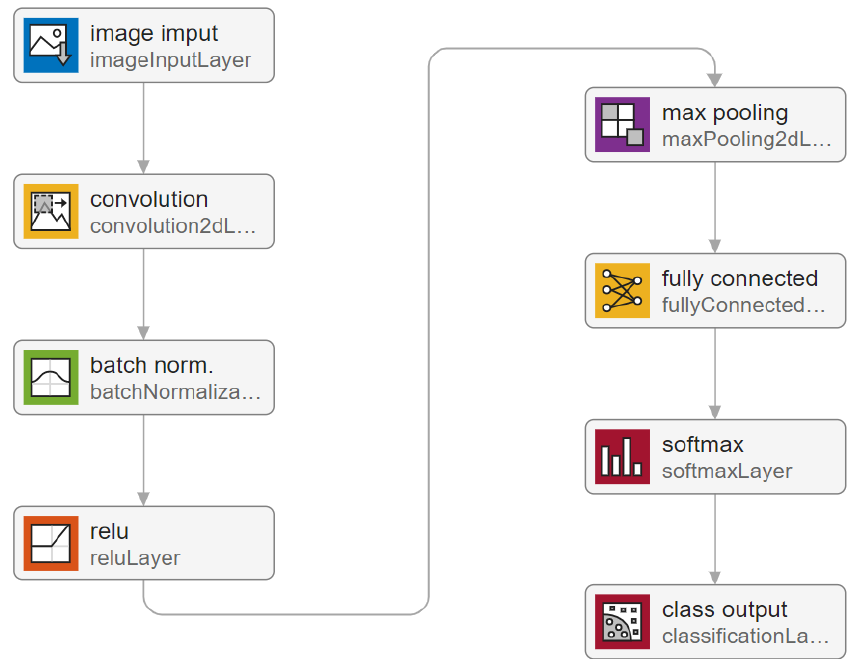
Figure 6. Diagram of the operation of the Convolutional Neural Network used in the study drawing from MATLAB R2021a, MathWorks (Natick, MA, United States).